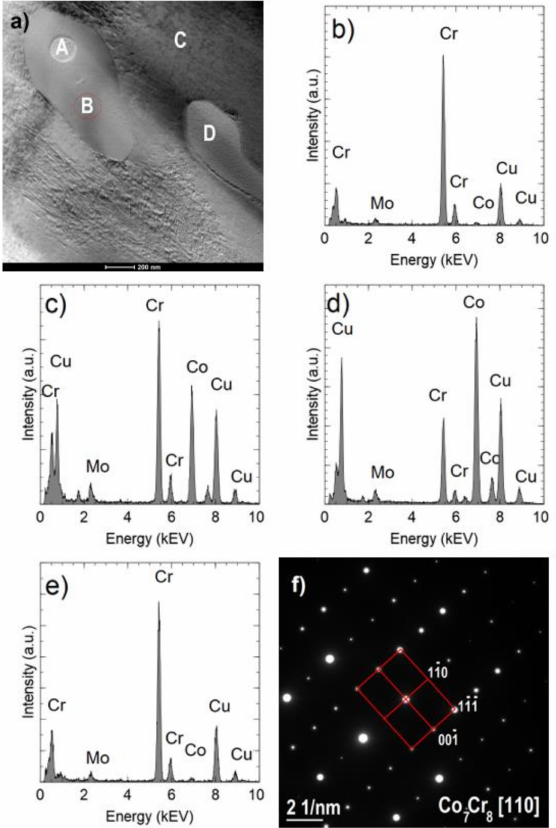
Figure 10. Precipitates in the sample sintered in N 2 -5%H 2 at 1350 ◦ C. STEM-BF image ( a ). The result of chemical analysis in the area indicated by A (Cr 97% at., Co 1% at., Mo 2% at.) ( b ), in the area indicated by B (Cr 56% at., Co 39% at., Mo 5% at.) ( c ), in the area indicated by C (Cr 29% at., Co 67% at., Mo 4% at.) ( d ), in the area indicated by D (Cr 92% at., Co 2% at., Mo 6% at.) ( e ); SAED electron diffraction pattern obtained for the B area ( f